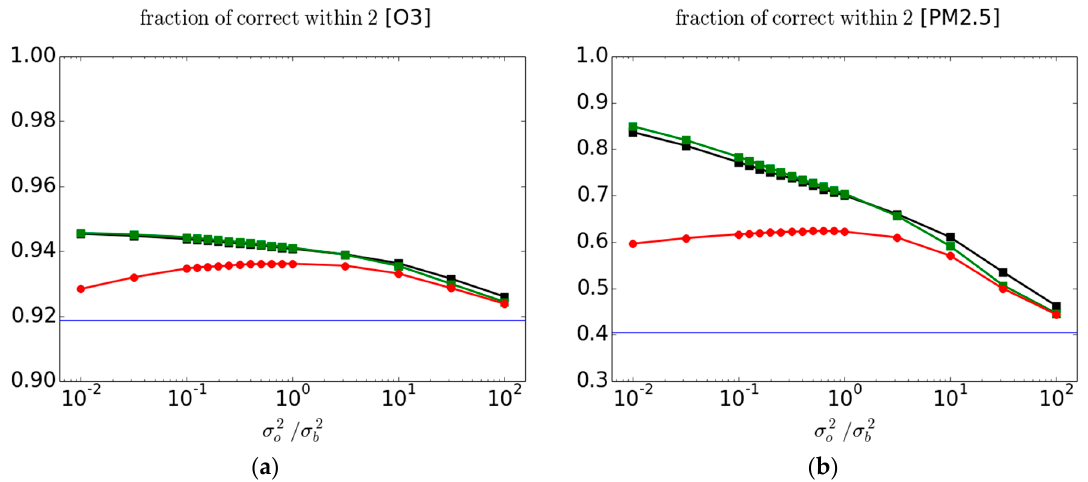
Figure 4. FC2 for ( a ) O 3 and ( b ) PM 2.5 for both active and cross-validation passive observations as a function of 22 / bo σσγ= . The red, black and green curves are as in Figure 2.